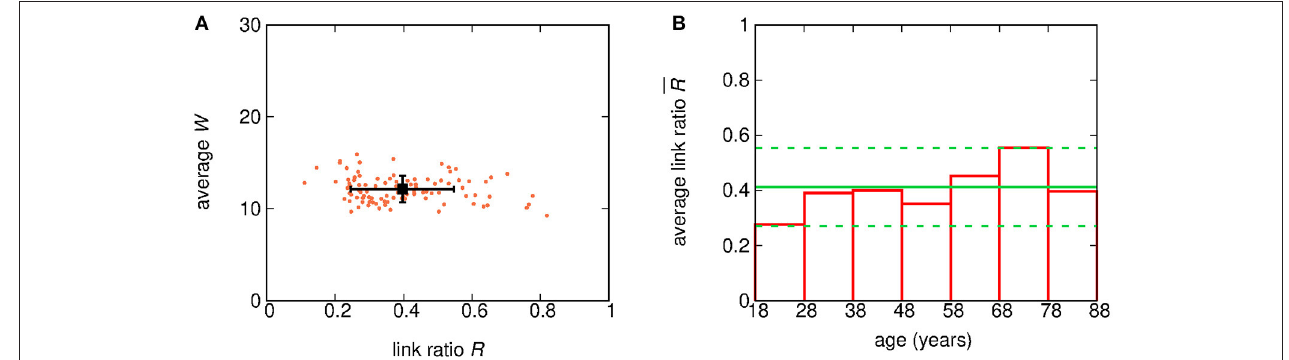
FIGURE 3 | (A) Scatter plot of the ratio R and the average W for each of the 100 subjects. Each point corresponds to one subject. The coordinates of the black square dot correspond to the average R and W over all subjects, while errorbars show the related standard deviations. (B) Bar plot of the average R of the ratio R for subjects grouped by age decade. The green solid line shows the grand-mean value of R , while green dashed lines bound the 95% (2 σ ) confidence region for R .